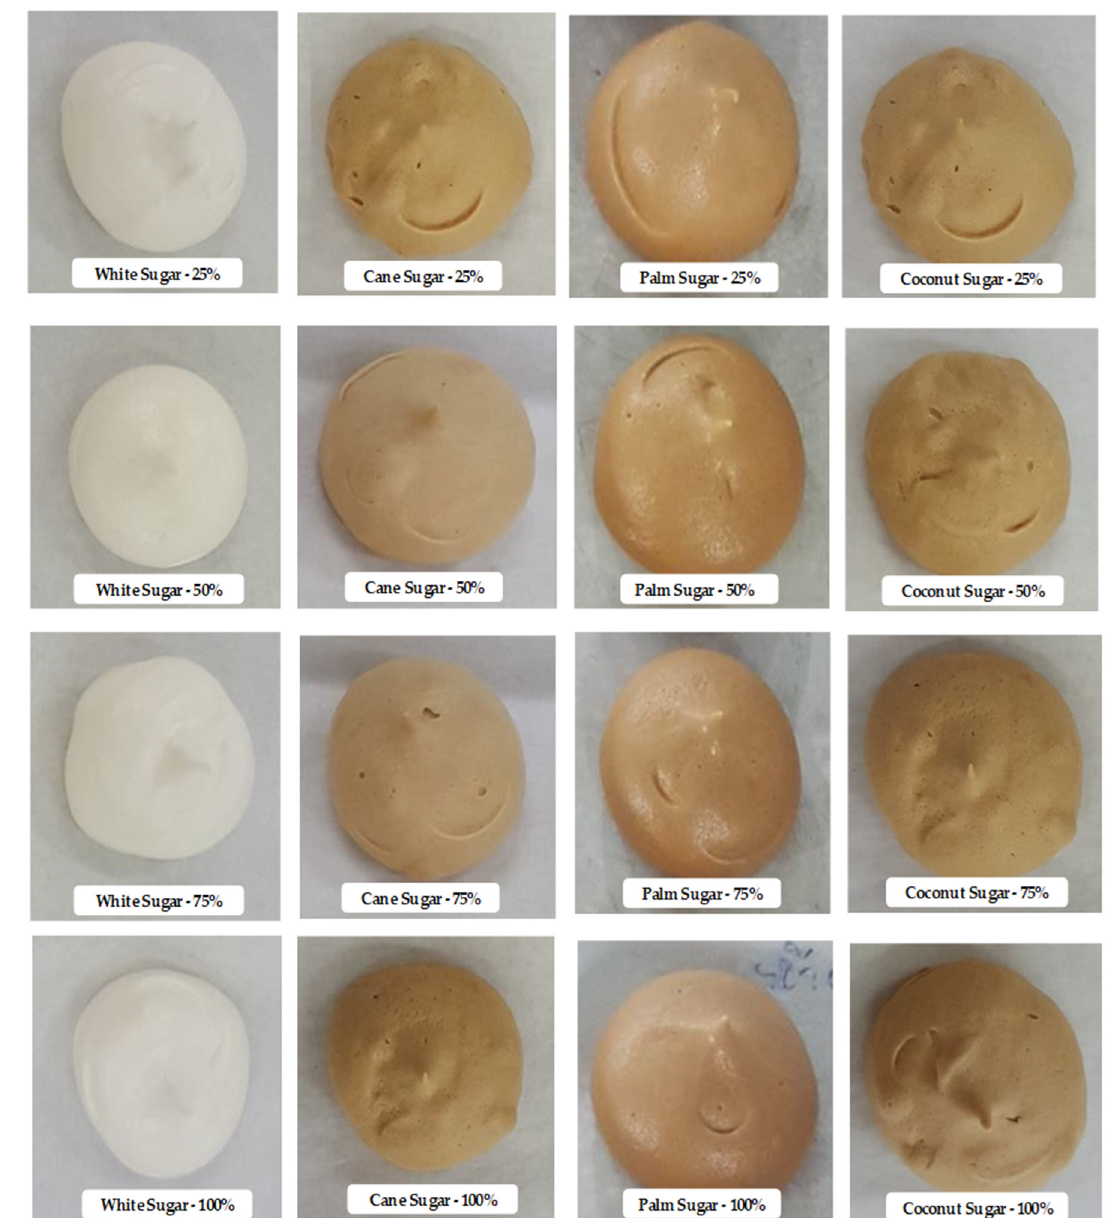
Figure 2. Pictorial reference of salted duck egg white meringues prepared with alternative types of sugar at various levels in the formulation.